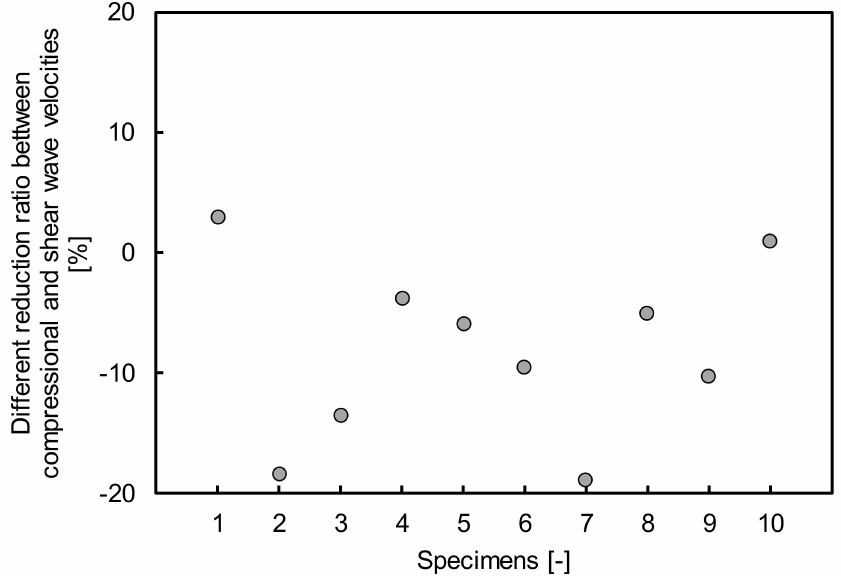
Figure 7. Di ff erent reduction ratios for compressional and shear wave velocities. The 1, 2, 3, 4, 5, 6, 7, 8, 9, and 10 denote samples albite 1, albite 2, albite 3, albite 4, quartz 1, quartz 2, quartz 3, biotite, calcite, and chlorite, respectively. Each di ff erence was calculated by subtracting the shear wave reduction ratio from the compressional wave reduction ratio. As such, a negative value shows that shear wave velocities significantly decreased due to